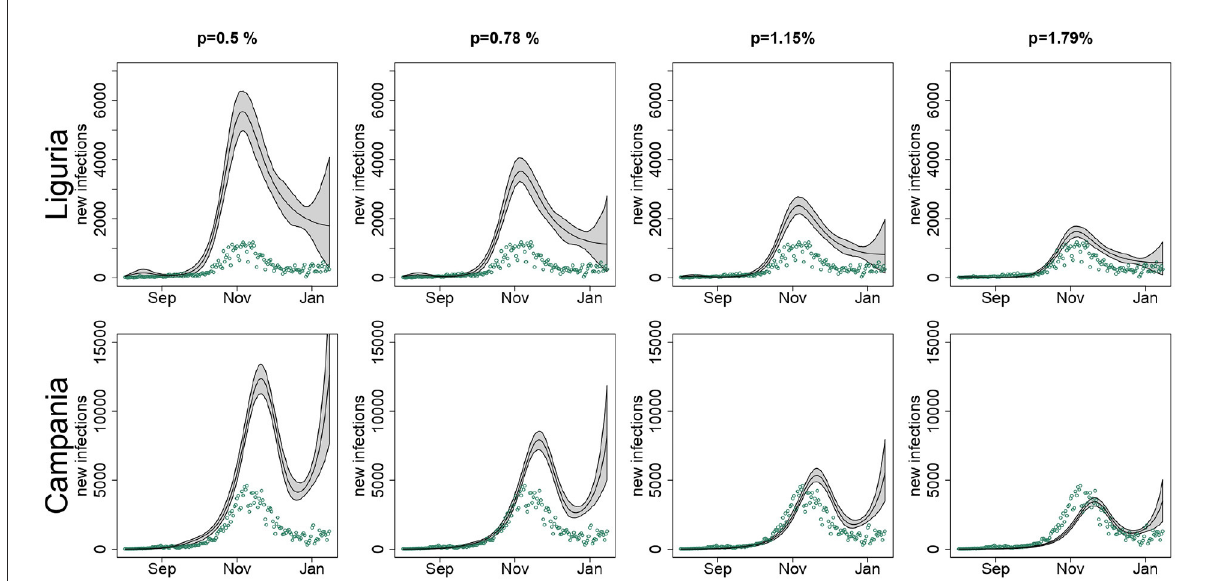
FIGURE6 Estimated number of new infections (black line) in Liguria and Campania with pointwise 90 % confidence bands, when setting in the SIRD model the infection fatality rate p to 0.5, 0.78, 1.15, and 1.79 % , along with the observed number of new notified infections (green points), by region; T = 14